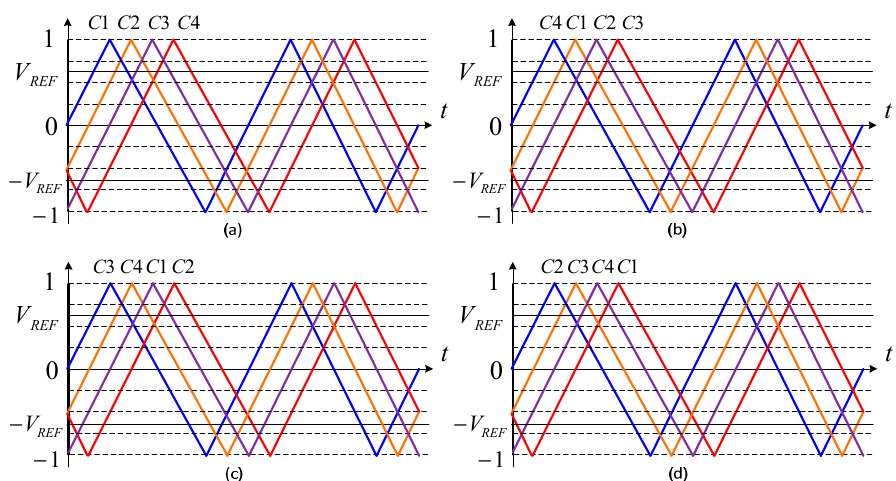
Figure 8. Four H-bridge CHB inverter switching sequences: ( a ) 1234, ( b ) 4123, ( c ) 3412 and ( d ) 2341 are equivalent under asymptotic assumption by circular permutation.